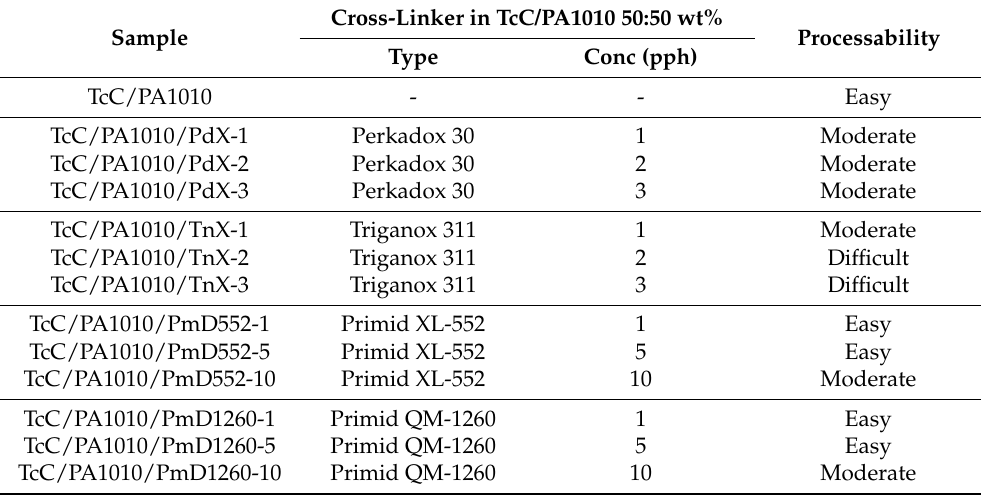
Table 1. Sample composition and the ease of processability during